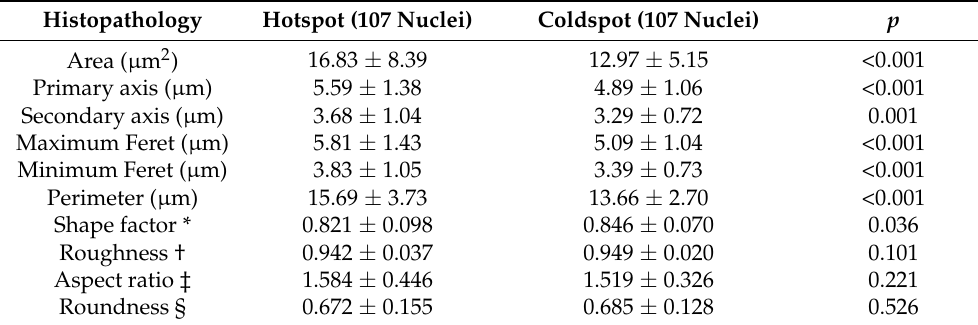
Table 4. Nuclear morphometric results of hotspots and coldspots on patches (400 × magnification).